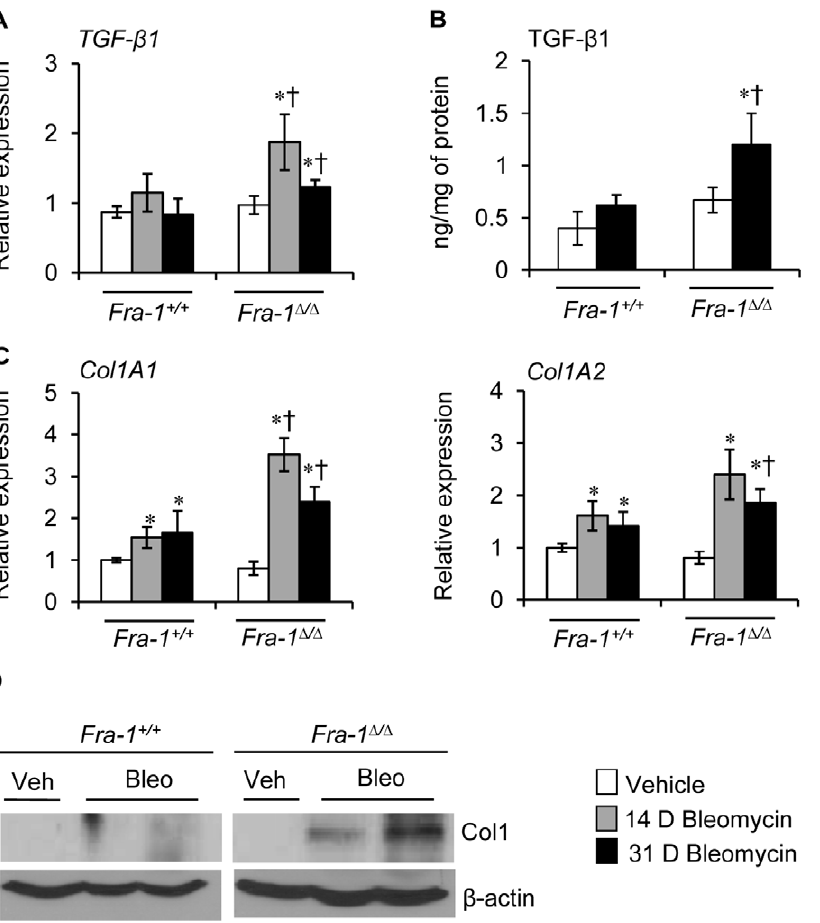
Figure 5. Fra-1 D / D mice exhibit deregulated profibrotic and fibrotic gene expression following bleomycin instillation. Transcript expression was compared with 31 days PBS control mice. A: TGF- b 1 expression in the lungs of mice treated with PBS or bleomycin as analyzed by real-time RT-PCR (n=4 2 6). B: TGF- b 1 expression at day 31 following PBS or bleomycin instillation as detected by ELISA (n=5). C: Col1A1 and Col1A2 expression as detected by real-time RT-PCR (n=4 2 6). D: Col1 and b -actin expression at day 31 following bleomycin instillation as detected by immunoblot. p , 0.05, PBS vs bleomycin; { p , 0,05, Fra-1 D / D vs Fra-1 + / + mice.